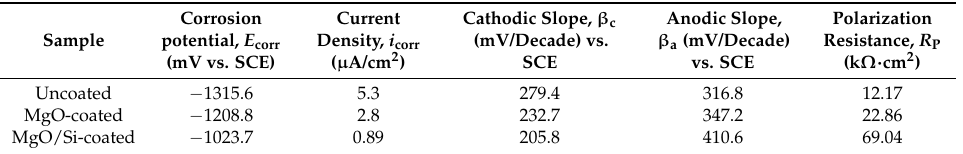
Table 3. Electrochemical parameters of the uncoated and MgO- and Si/MgO-coated Mg/HA/TiO 2 nanocomposites in SBF solution obtained from the polarization